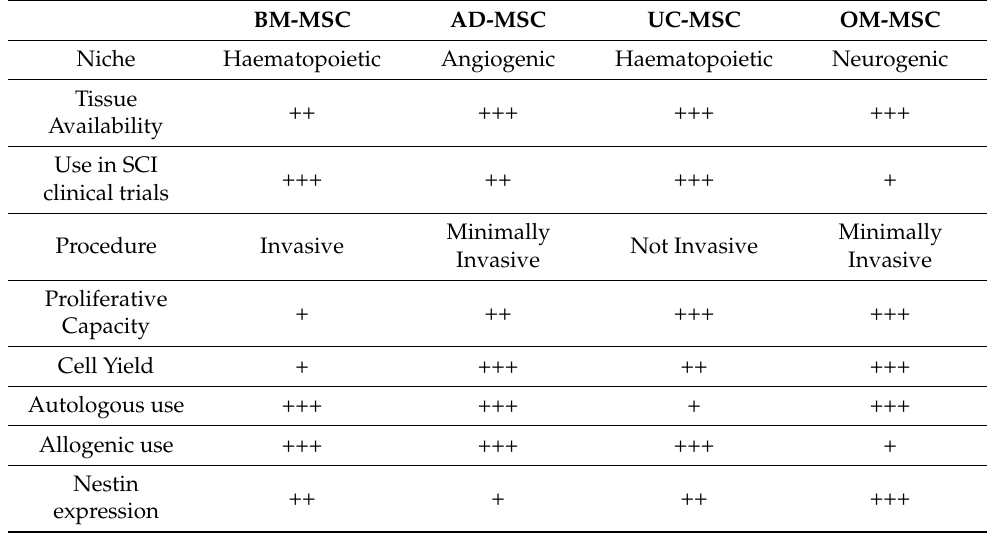
Figure 3. Factors which can affect MSC repair benefits. Schematic representation of the potential MSC heterogeneity because of their different tissue source and the intrinsic and extrinsic factors that could influence their repair benefits after SCI. Table 1. Comparison of key characteristics of MSCs harvested from different